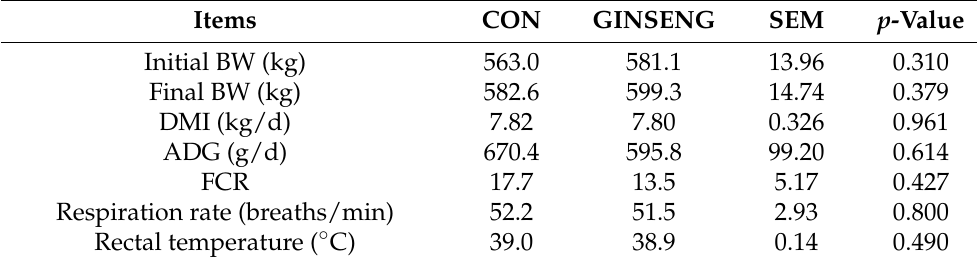
Table 5. Growth performance, respiration rate, and rectal temperature of heat-stressed Hanwoo steers supplemented with red ginseng byproduct.